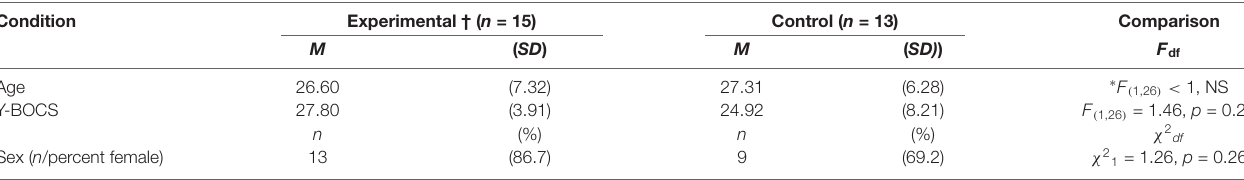
TABLE 1 | Demographic and Clinical Characteristics of Participants a .